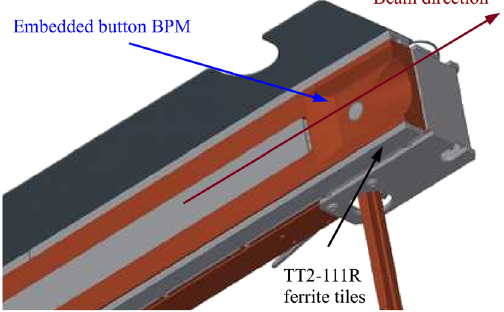
FIG. 2. TCT design with embedded BPMs and TT2-111R ferrite tiles.